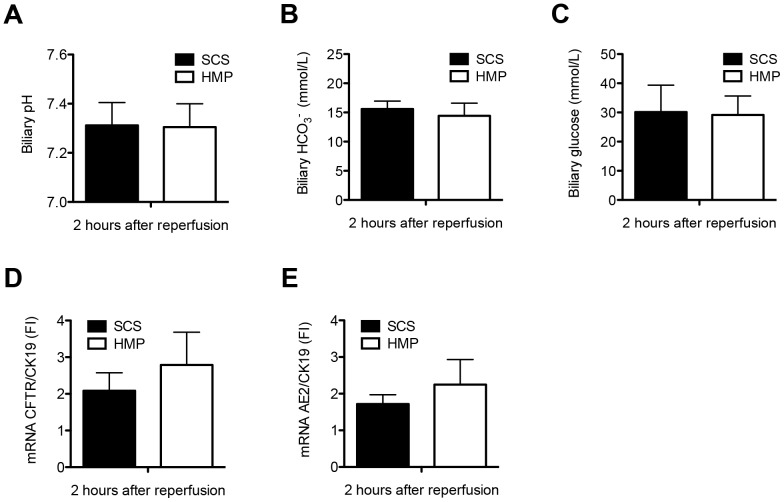
Comparison of functional parameters of biliary epithelial cell function in DCD livers that were preserved by either 4 h of oxygenated HMP or 4 h of SCS and subsequently reperfused for 2 h by normothermic ex vivo sanguineous perfusion.There were no significant differences in biliary pH (Panel A), biliary bicarbonate (Panel B) and glucose concentration (Panel C) at 2 h after reperfusion between the two groups. Relative mRNA expression of the main cholangiocyte transporter proteins involved in biliary bicarbonate secretion, CFTR (cystic fibrosis transmembrane conductance regulator; ABC35) (Panel D) and AE2 (anion exchanger 2; SLC4A2) (Panel E) after 2 h of ex vivo sanguineous reperfusion of DCD livers that were preserved by either 4 h of oxygenated HMP or SCS. There were no significant differences between the two groups.